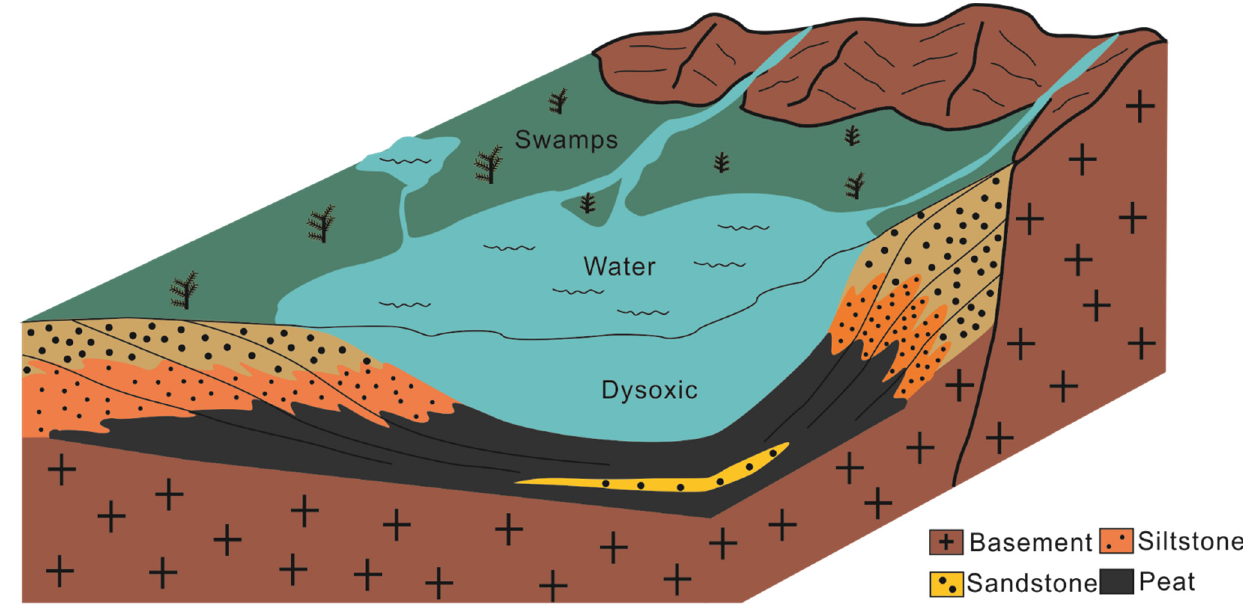
Figure 8. Deposition diagram showing potential peat/coal-forming environments in the Yili Basin, Northwest China (Redrawn from [100]).